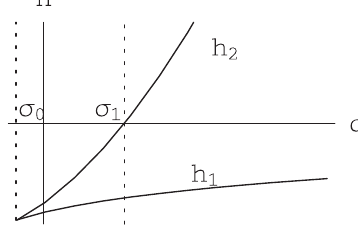
As the graph shows, the curves h h hσ -plane into 1 and 2 divide the three different domains: h < h 1 , h < h < h h > h 1 2 and 2 , that does not contain multiple roots of the cu- bic f ( u ) . In the domain beneath the curve h 1 and above the curve h 2 the function f ( u ) has only one real root. At every point of critical curves one of the extrema points of the cubic f ( u ) touches the abscissa axis